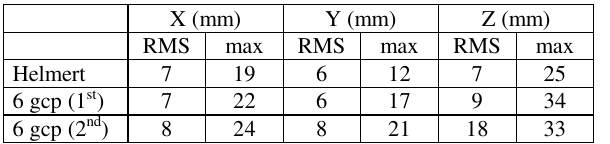
Table 8. Statistics of the discrepancies with the two methods based on 19 gcp taken from the DSM.